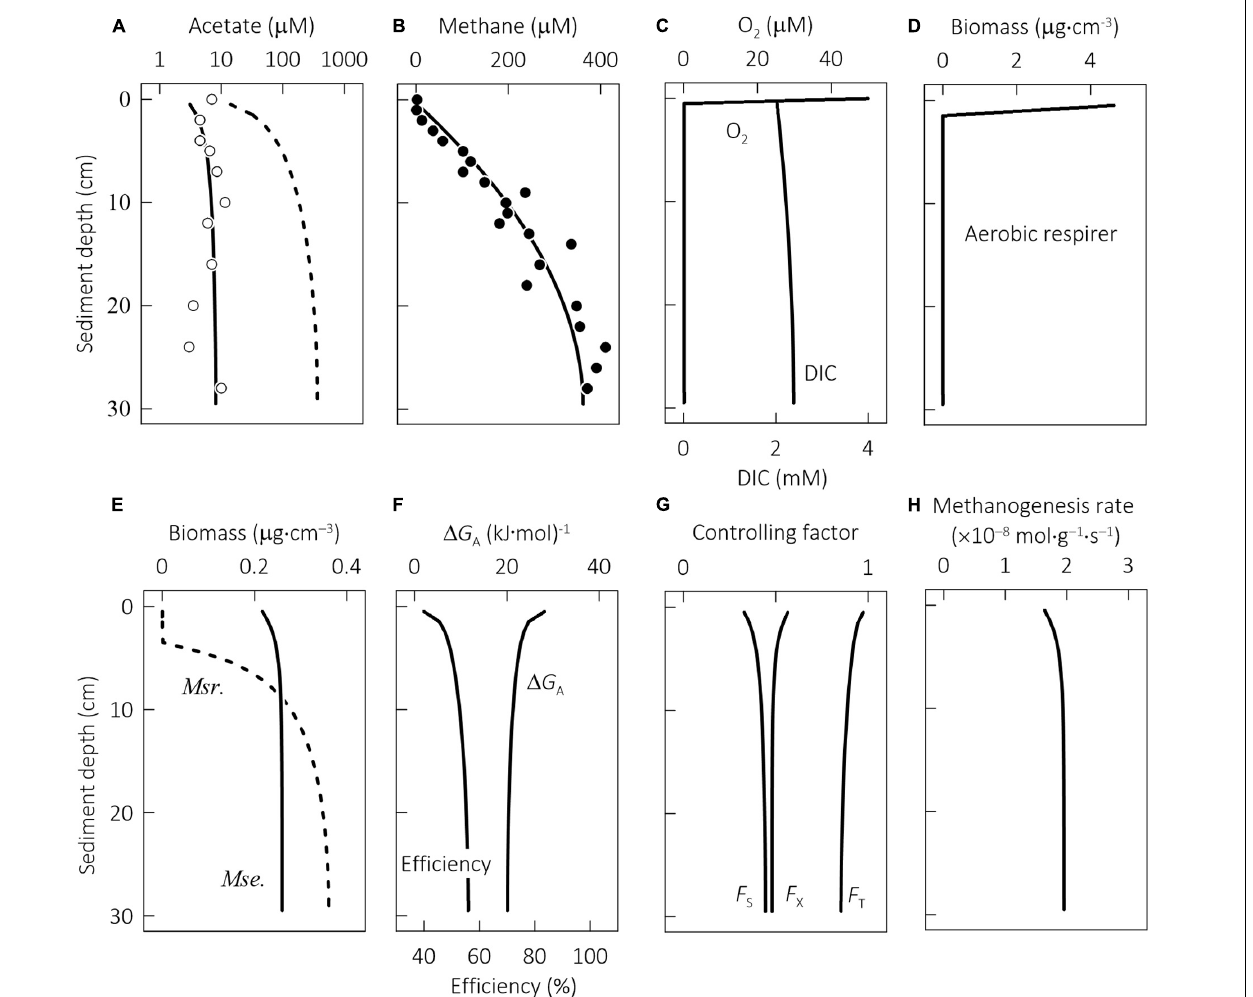
FIGURE 6 | Results at steady state of a reactive transport model constructed for microbial metabolisms in the profundal sediments of Lake Constance, Germany, showing along the sediment depth the concentrations of acetate (A) , methane (B) , dioxygen (O 2 ), dissolved inorganic carbon (DIC, C ), biomass of aerobic respirer (D) , Methanosarcina ( Msr. ) and Methanosaeta ( Mse. , E ), the available energy, the thermodynamic efficiency (F) , the kinetic factor of acetate F S , the thermodynamic potential factor F T , the biomass capacity factor F X (G) , and methanogenesis rate per unit biomass (H) . Data points are the results of previous field investigations with samples recovered from the deepest part of the lake at 143 m depth (Schulz and Conrad, 1995); solid lines are the simulation results that track